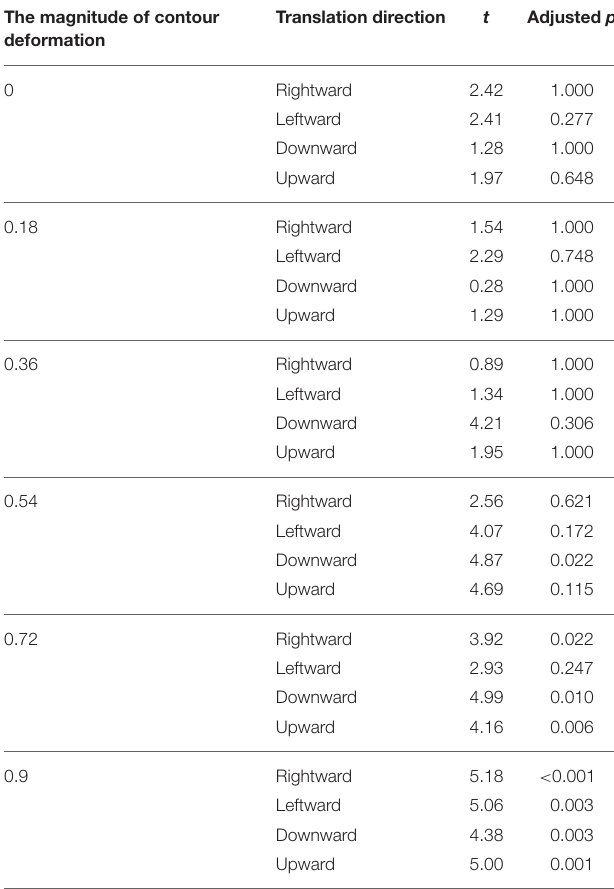
TABLE 1 | The results of multiple comparison tests with the Holm–Bonferroni test between the mean rating score for each level of contour deformation and the value of “3” (the vague impression) in Experiment